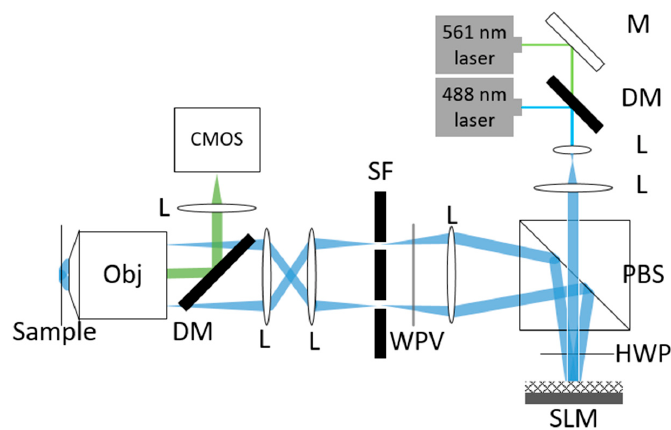
Figure 5. Structured light super-resolution imaging system built in this paper. M is a mirror, DM is a dichroic mirror, L is an achromatic lens, PBS is a polarization beam splitter, HWP is an achromatic 1/2 wave plate, SLM is a spatial light modulator, WPV is a zero-order vortex half-wave plate, SF is a spatial light filter, MO is a microscopic objective lens, CMOS is a detection camera.